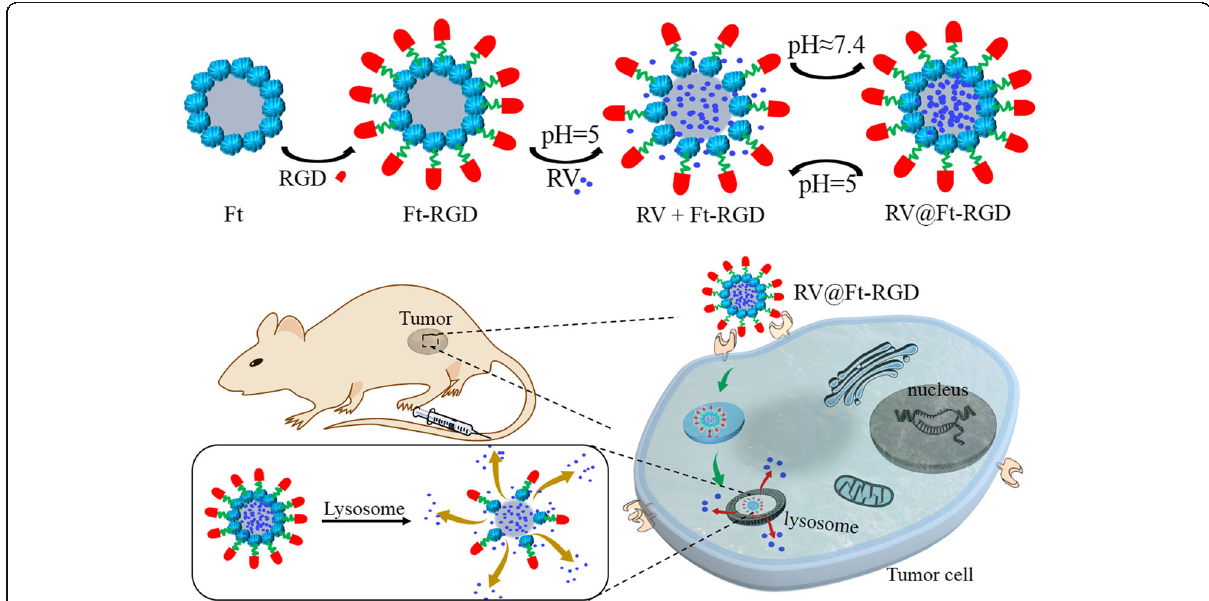
Fig. 1 A schematic illustration of RV@Ft-RGD preparation and tumor-targeted